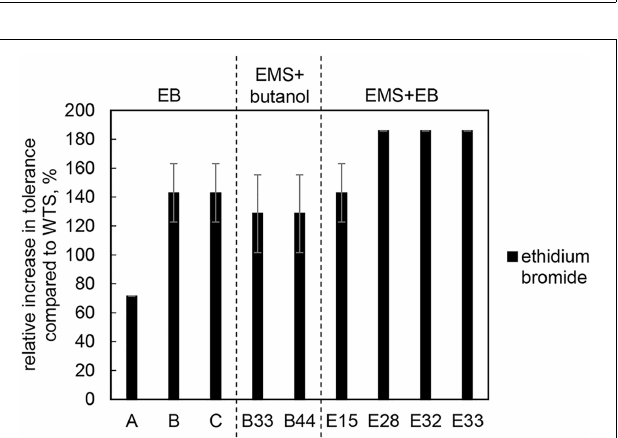
FIGURE 3 | Relative increase in tolerance to EB of mutant strains compared to C. beijerinckii NRRL B-598 (WTS). Tolerance levels are expressed as the maximum concentration of substances in TYA medium at which growth of the strains was still detectable. Original tolerance of WTS to EB was 1.75 ± 0.4 mg/L. EB – strains obtained by random chemical mutagenesis using EB as a mutagenic agent, when strains were selected directly on